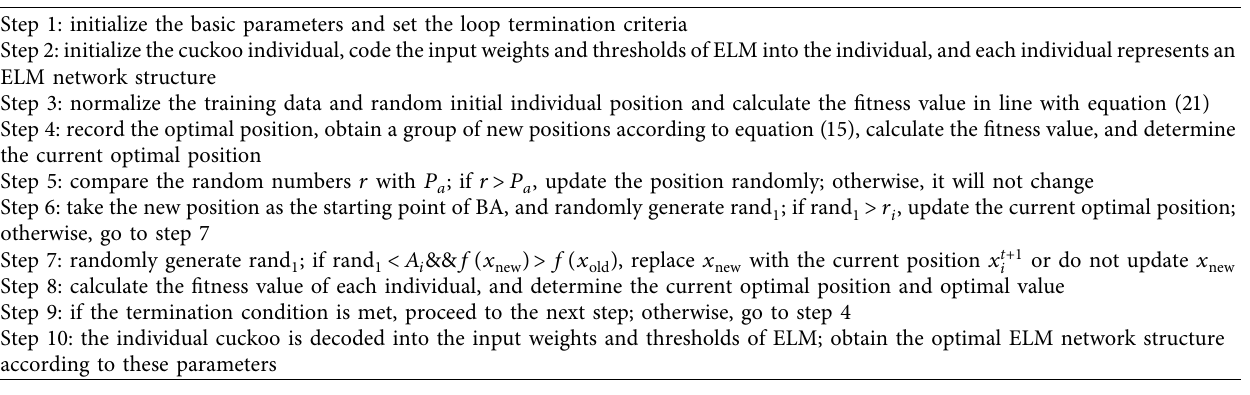
Table 2: Steps of the BACS − ELM learning algorithm.